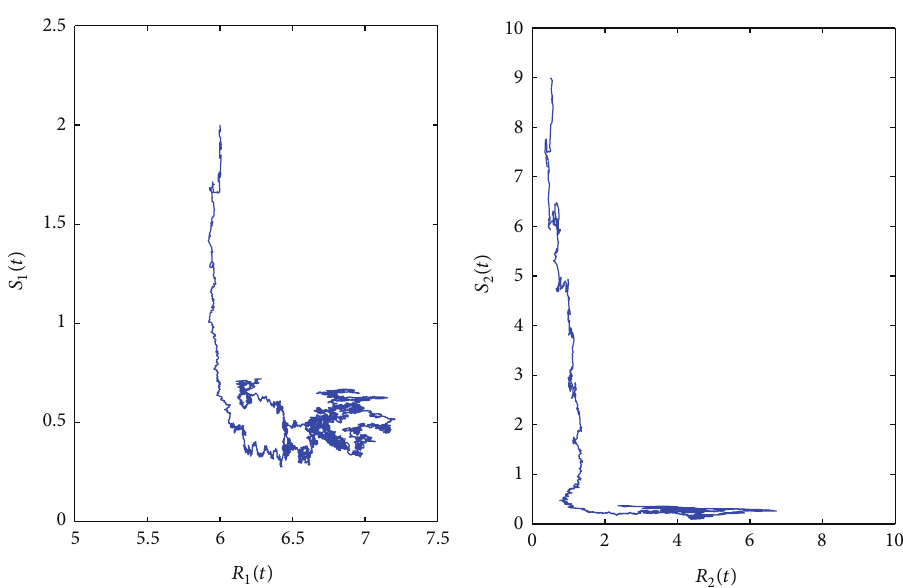
Figure 6: The relation between 𝑆 𝑘 and 𝑅 𝑘 for the stochastic SIRS